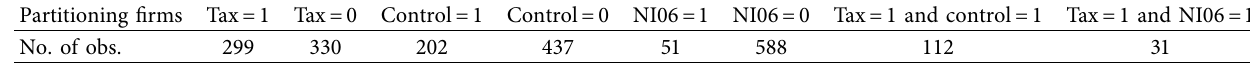
Table 3: The quantity distribution of different types of